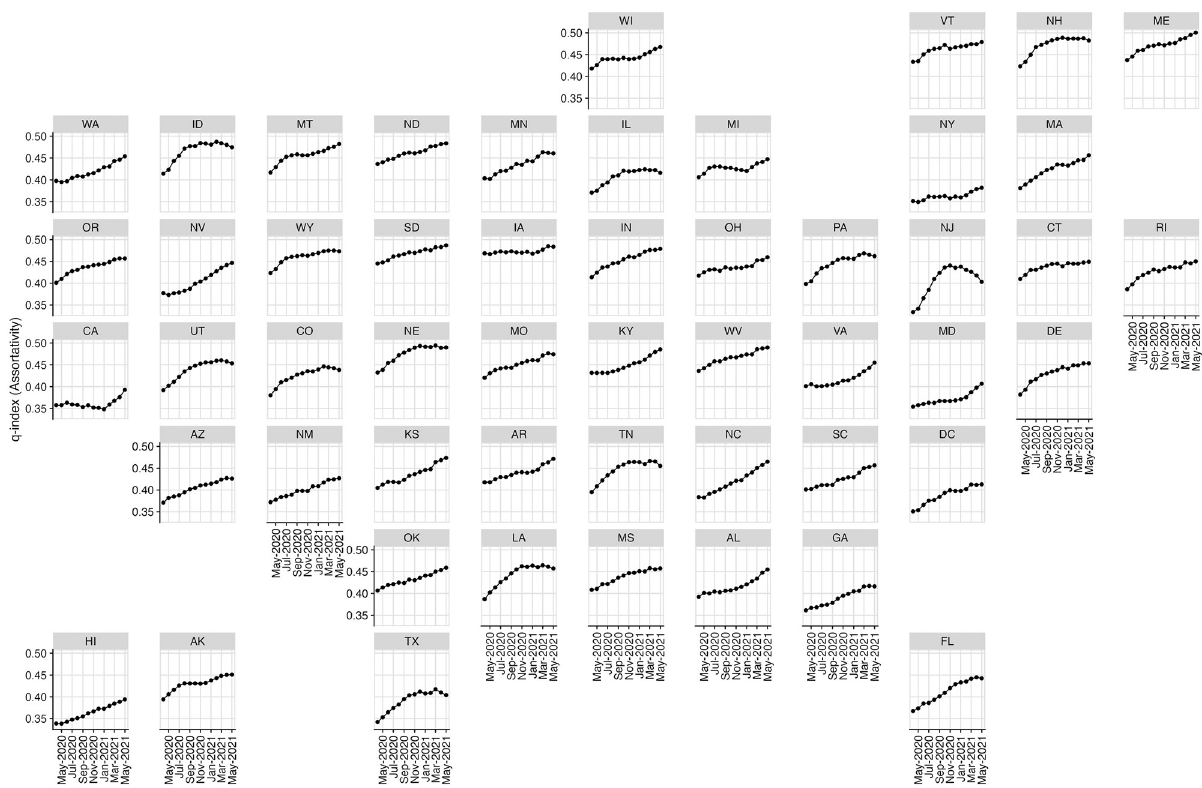
Fig 5. Change in age assortativity, as measured by the q-index, over the course of the pandemic. A higher q-index value corresponds to higher age assortativity.